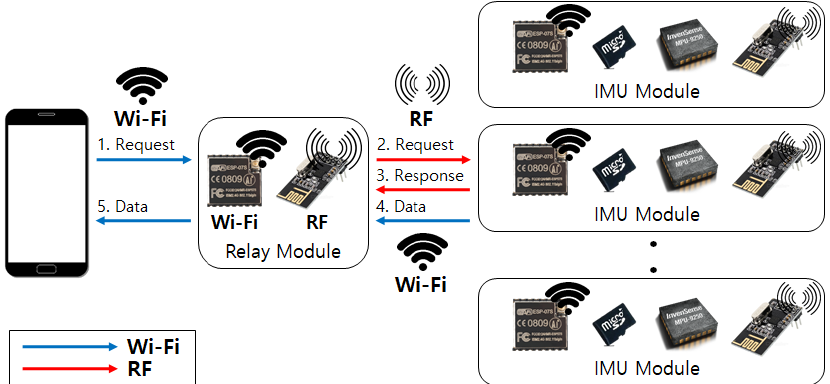
Figure 2. Testbed system consists of a mobile device, a relay module, and multiple IMU sensor devices. (1) Request for soft-AP setting, (2) Radio Frequency (RF) connection request, (3) Response on connection establishment, (4)–(5) Activity data